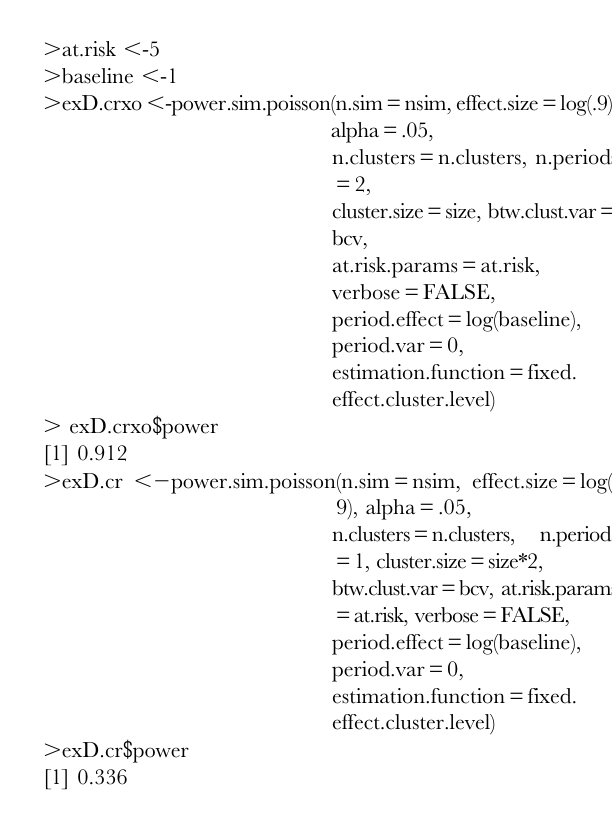
Figure 1. Power curves from Examples A and B. These curves show the relationship of power with the number of clusters. The points show simulated power for 1000 datasets with a smoothed line drawnthrough the data to highlight the overall pattern. The solid line and gray points represent the simulations with constant baseline rates (Example A) and the open circles and dashed line represent the simulations with time-varying baseline rates (Example B).